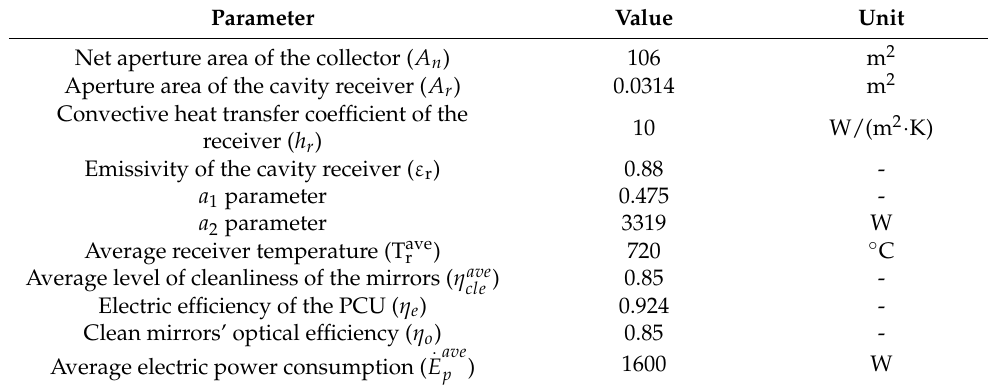
Table 5. Main parameters used as input to the analytical model of the dish–Stirling system of Palermo. Parameter Value Unit Net aperture area of the collector ( A n ) 106 m 2 Aperture area of the cavity receiver ( A r ) 0.0314 m 2 Convective heat transfer coefficient of the 10 W/(m 2 · K) receiver ( h r ) Emissivity of the cavity receiver ( ε r ) 0.88 - a 1 parameter 0.475 - a 2 parameter 3319 W Average receiver temperature (T ave r ) 720 ◦ C Average level of cleanliness of the mirrors ( η ave ) 0.85 - cle Electric efficiency of the PCU ( η e ) 0.924 - Clean mirrors’ optical efficiency ( η o ) 0.85 - . ave 1600 E Average electric power consumption ( p )